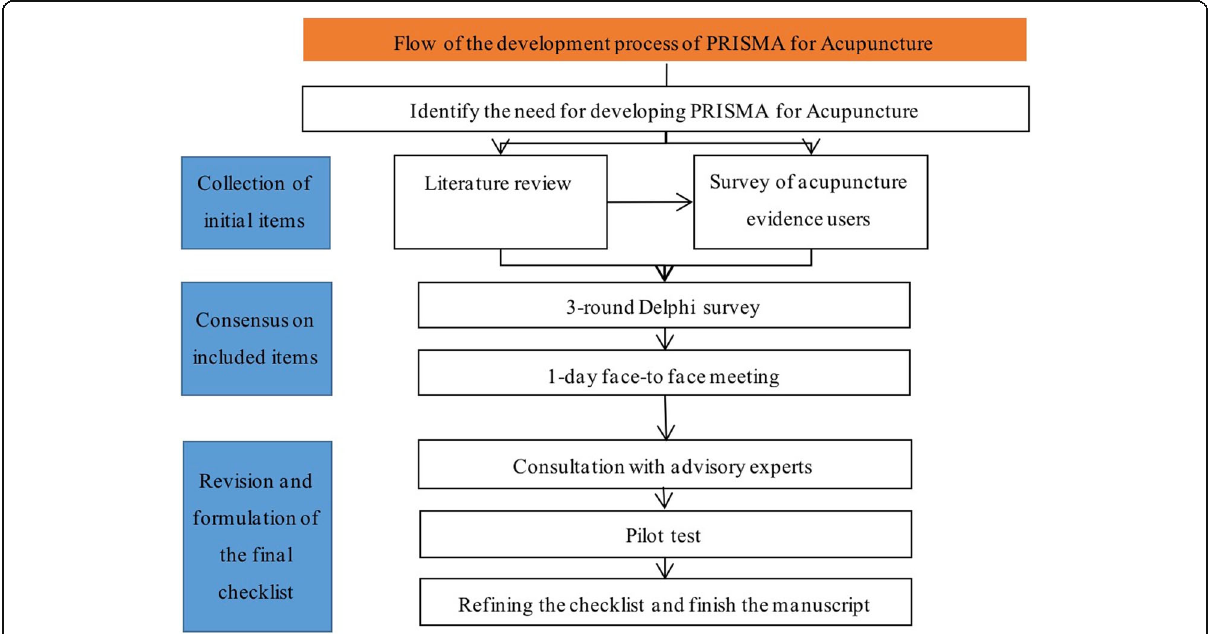
Fig. 1 The development process of the PRISMA for Acupuncture